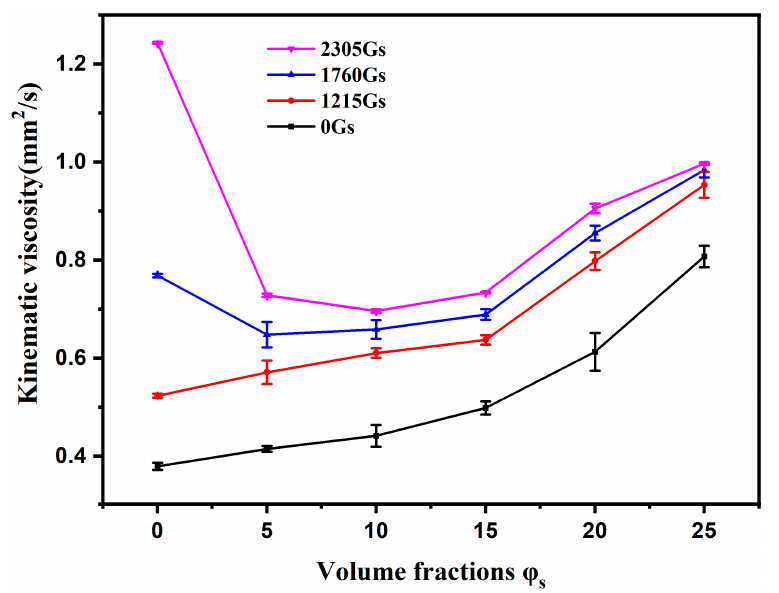
Figure 3. Variation of the kinematic viscosity of tritium breeder composite with different Li 2 TiO 3 micro-powders fractions.